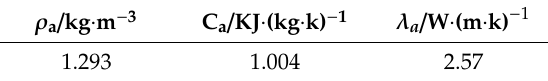
Table 3. Performance parameters of air [32].